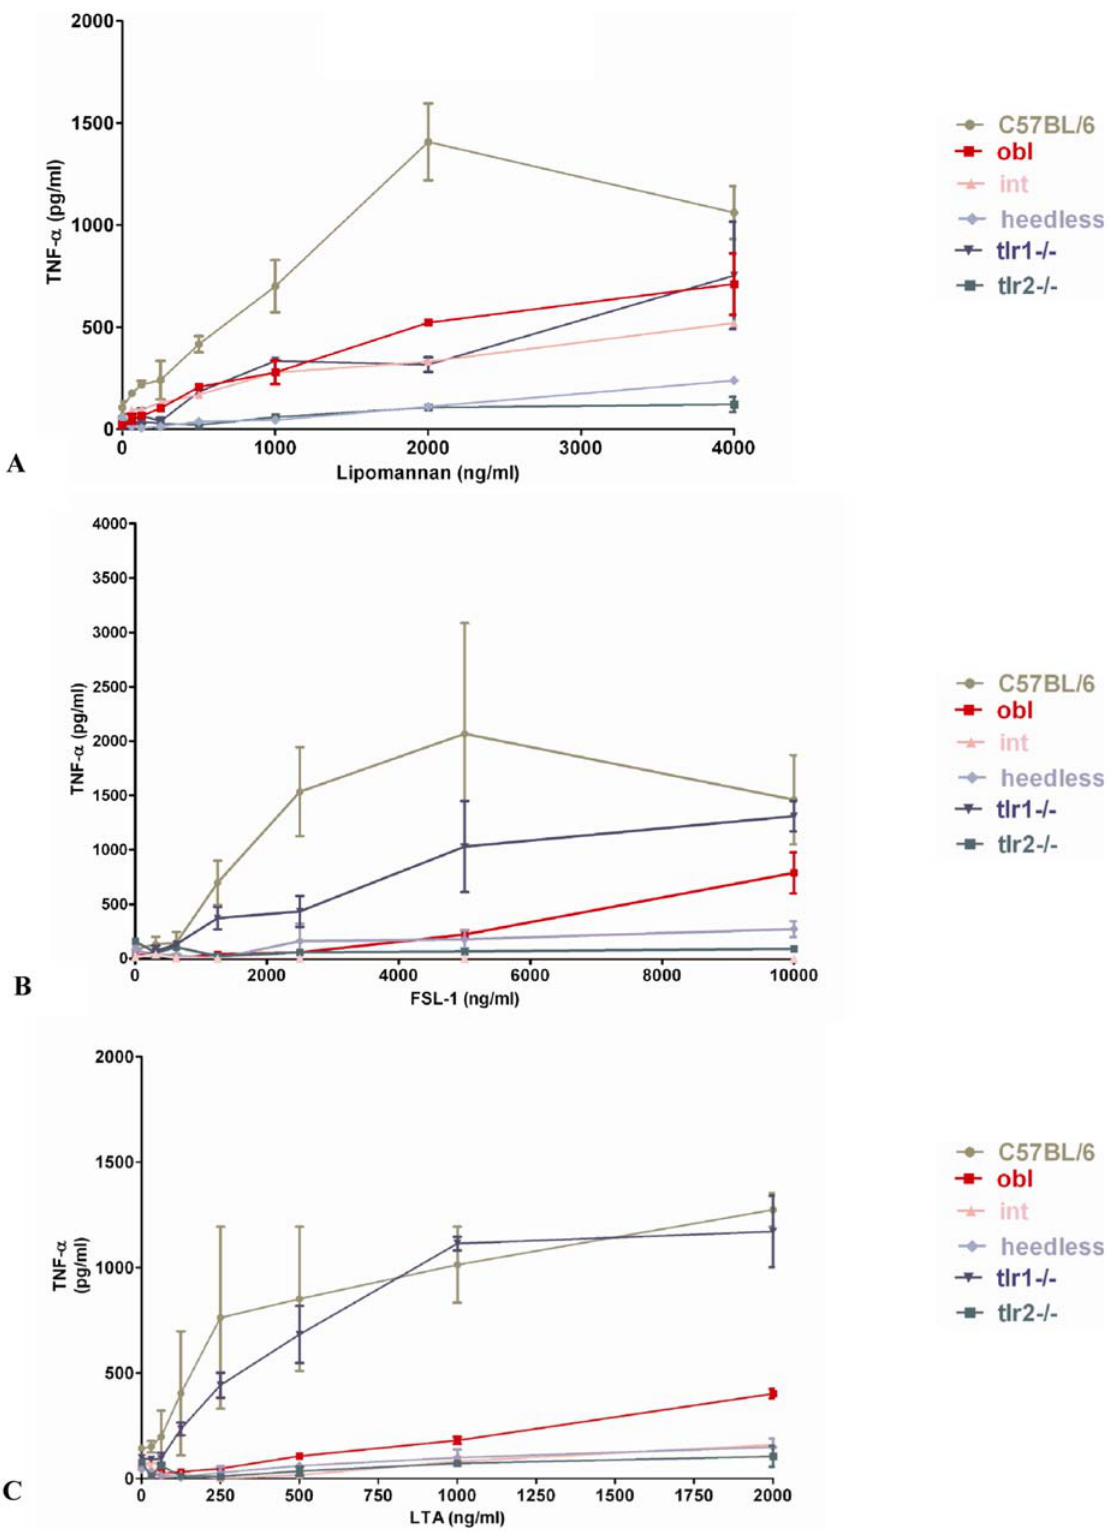
Figure 3. Expression of TLR2, CD14 and CD36 in murine macrophages are relevant for secretion of TNF- a by the following bacterial components: ( A ) lipomannan from M. smegmatis, ( B ) FSL-1 fluorescein, and ( C ). LTA from S. aureus . Macrophages from C57BL/6 mice, heedless , insouciant (int), oblivious (obl), Tlr2 2 / 2 , Tlr1 2 / 2 were exposed to different concentrations of lipomannan from M. smegmatis, LTA from S. aureus and FSL-1 fluorescein for 4 hours at 37 u C. The amount of TNF- a secreted to the supernatant was determined by an L929 cell cytotoxic assay. Values are expressed as mean values + / 2 SEM (n=2 mice).